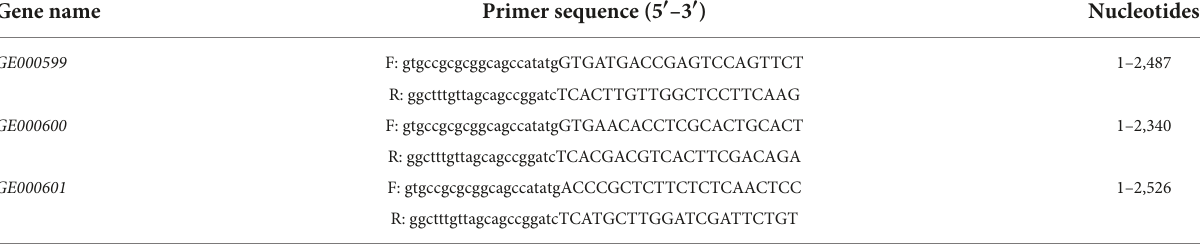
TABLE 1 Primers used for amplification of the target genes from the genomic DNA of Glutamicibacter halophytocola S2. Gene name Primer sequence (5 (cid:48) –3 (cid:48)